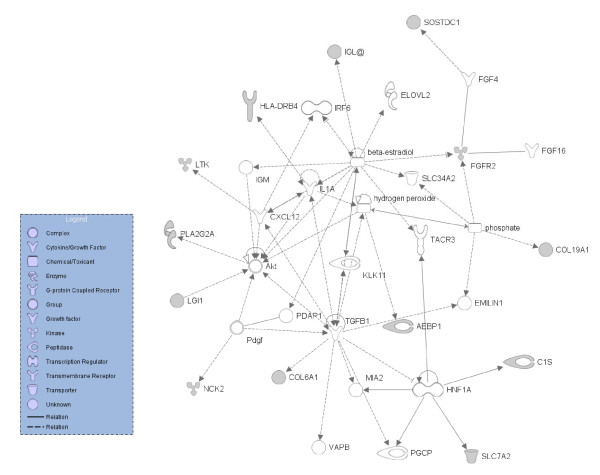
Ingenuity analysis of the cross section of genes previously identified in RPE studies[14]with genes highly expressed in the RPE transcriptome. The resulting network shows a connectivity chart illustrating biological functions comprising genes, proteins and ligands related to cell-cell signaling and cell-cell interaction. This network contains 13 of the 16 genes entered into the analysis. Filled objects represent the genes entered, empty objects are genes introduced by the ingenuity software creating a connection between the entered genes.